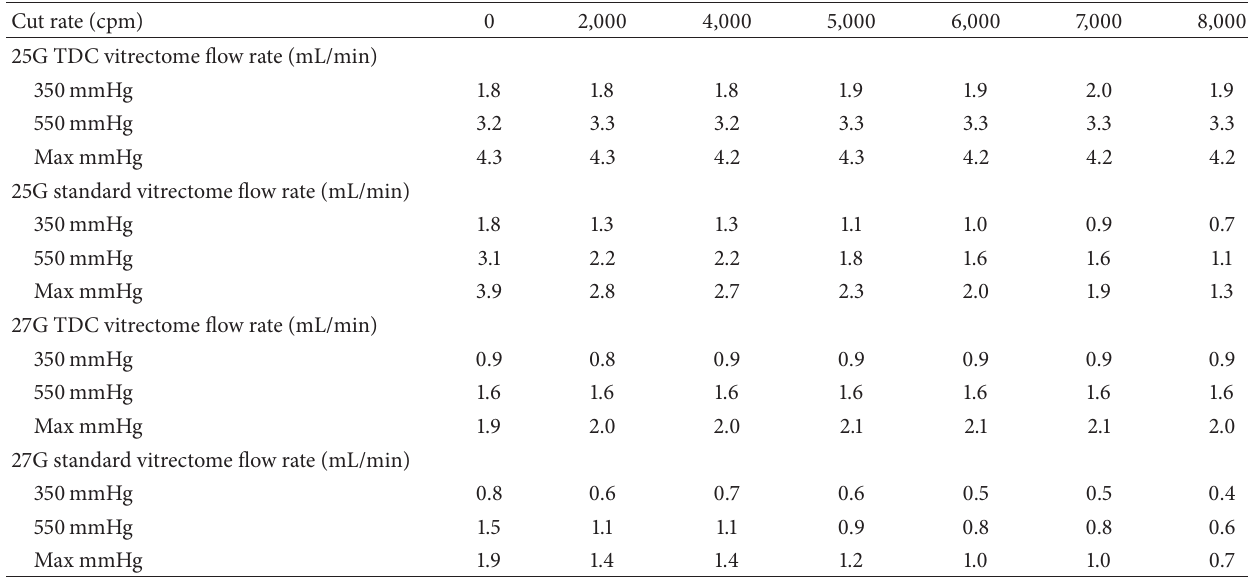
Table 1: Comparison of aspiration flow rates (mL/min) using TDC and standard single-cut vitrectomes connected to the EVA surgical system at varying cut rates and different vacuum pressures, in vitro tests performed using artificial vitreous humor as the aspirating fluid.